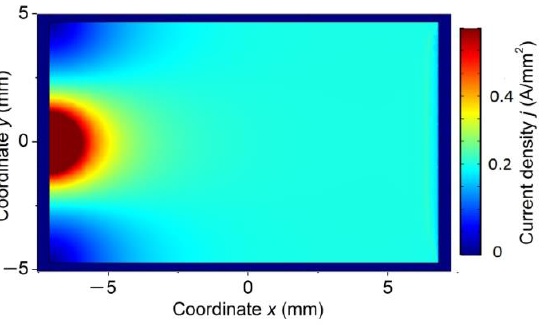
Figure 2. Spatial distribution of the electric current density in the upper electrode of “magnetic capacitor” for I = 100